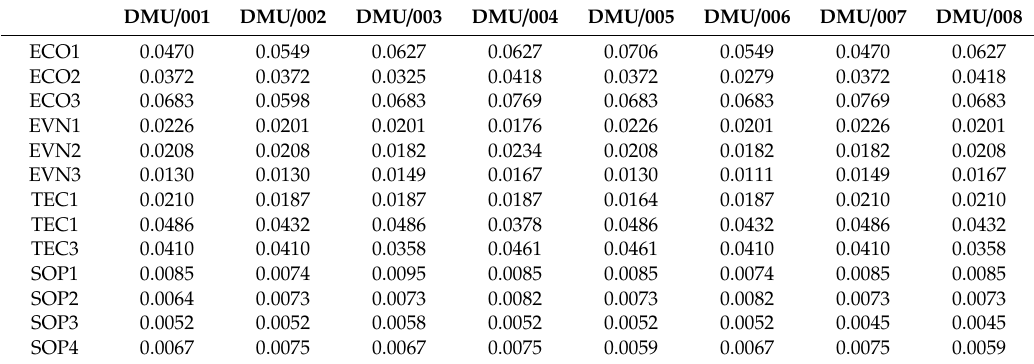
Table 4. Normalized weight matrix.